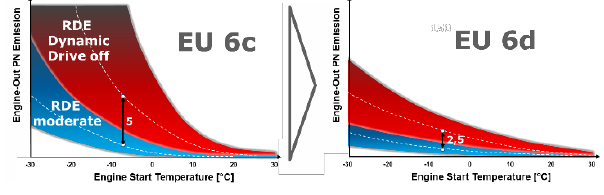
Fig. 9. Influence of start temperature and driving style on the engine-out particulate emissions in the RDE city section – TGDI engines